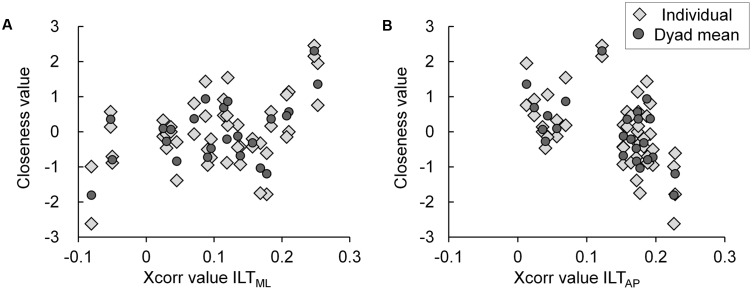
Scatter plots showing the data distribution between the Xcorr value of the ILT condition and the closeness value. In the individual (light gray diamond) and dyad mean (dark gray circle) distribution plots, (A) a positive association between the Xcorr value and the closeness value in the ML axis and (B) a negative association in the AP axis are shown. ILT, interpersonal light touch; ML, mediolateral; AP, anteroposterior; Xcorr value, peak cross-correlation coefficient.